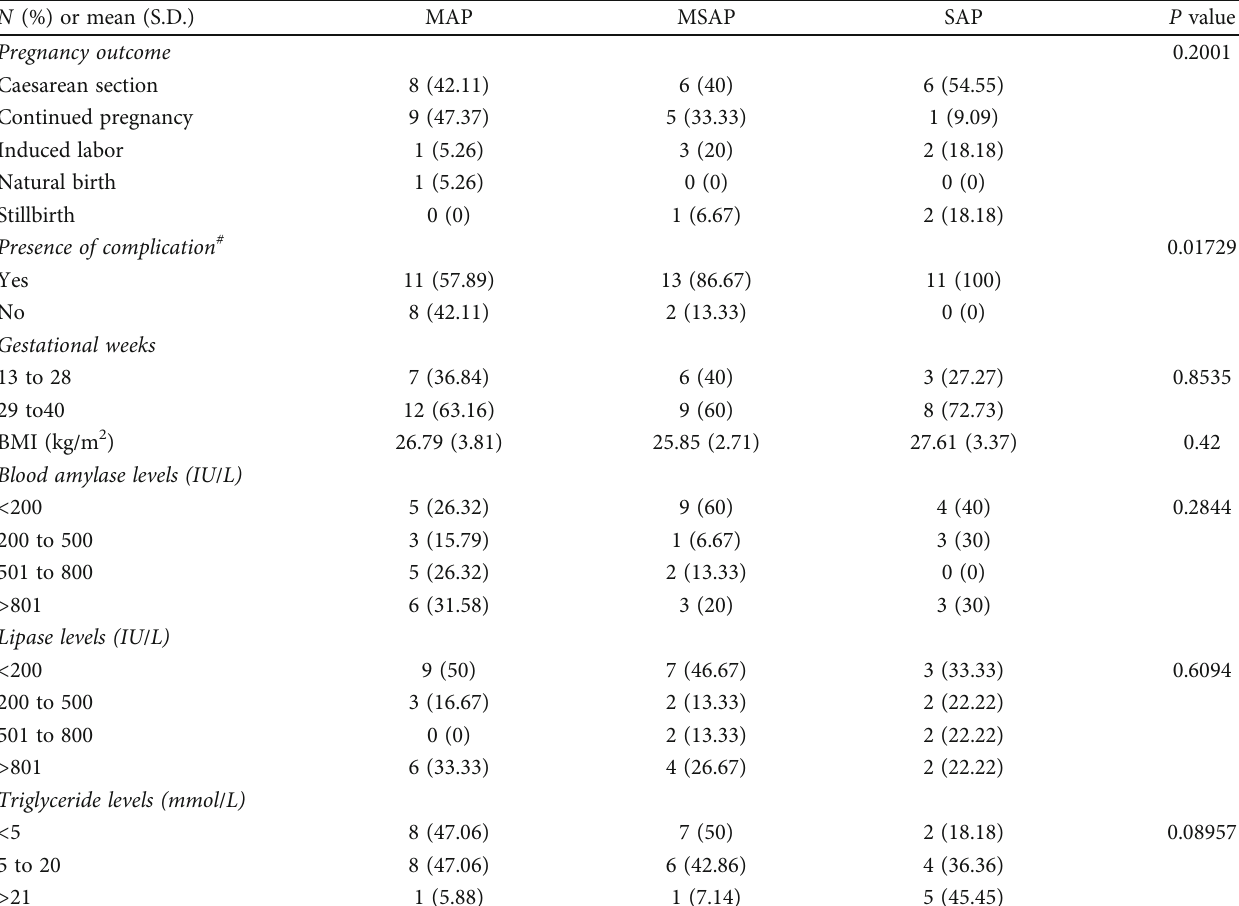
Table 3: Association between disease severity, clinical parameters, and pregnant outcomes. N (%) or mean (S.D.)